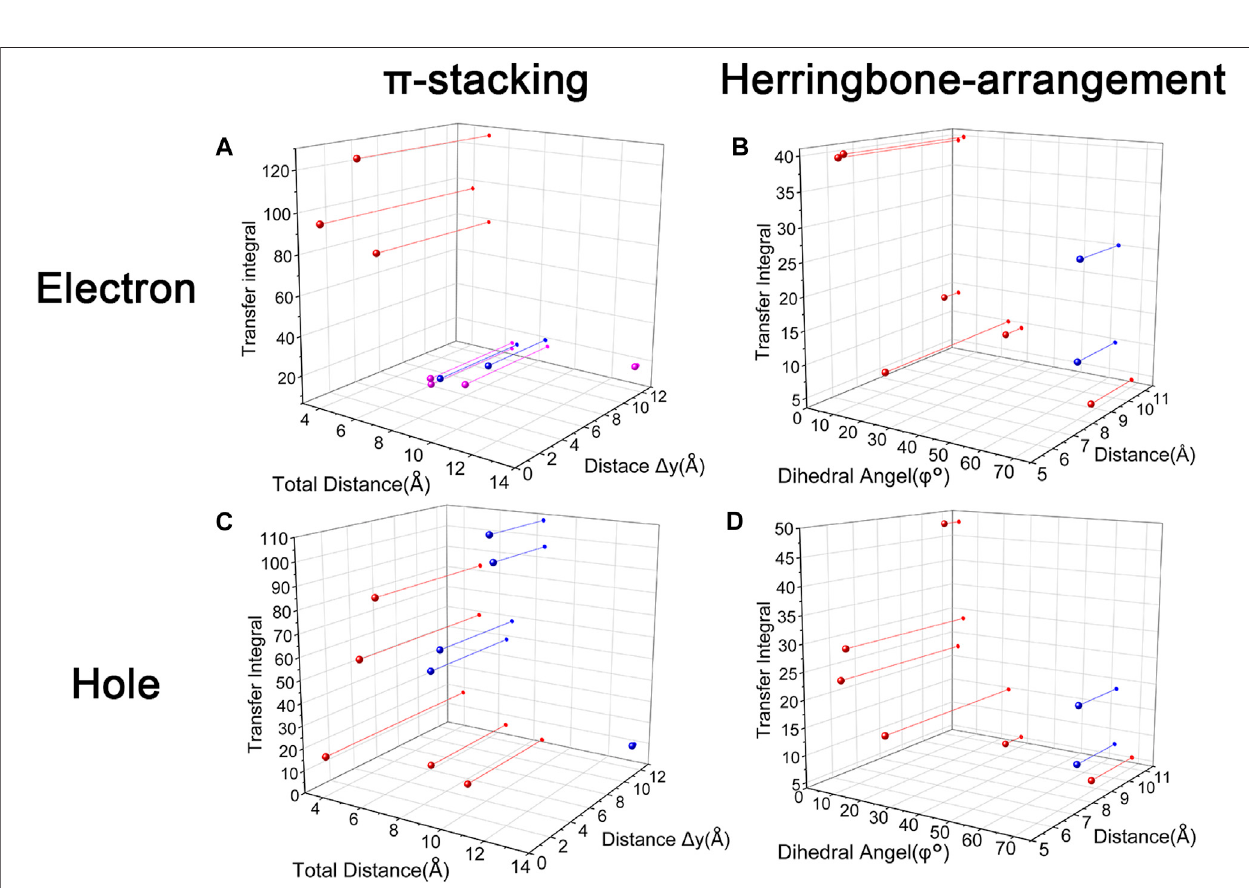
FIGURE13| Relationshipbetweentransferintegralandcrystalstructureinstackingandherringbonearrangement. (A) Red:LUMOsdistributedonbothmolecules with small slip distances. Pink: LUMOs distributed on both molecules with large slip distances. Blue: LUMOs distributed on one molecule. (B) Blue: The exception molecular of BOXD-o2. (C) Red: HOMOs are symmetrically distributed on each molecule. Blue: HOMOs are located on the overlap area. (D) Blue: The exception molecular of BOXD-o2.